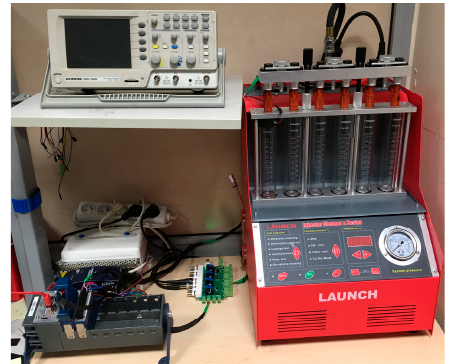
Figure 2. Experimental stand.